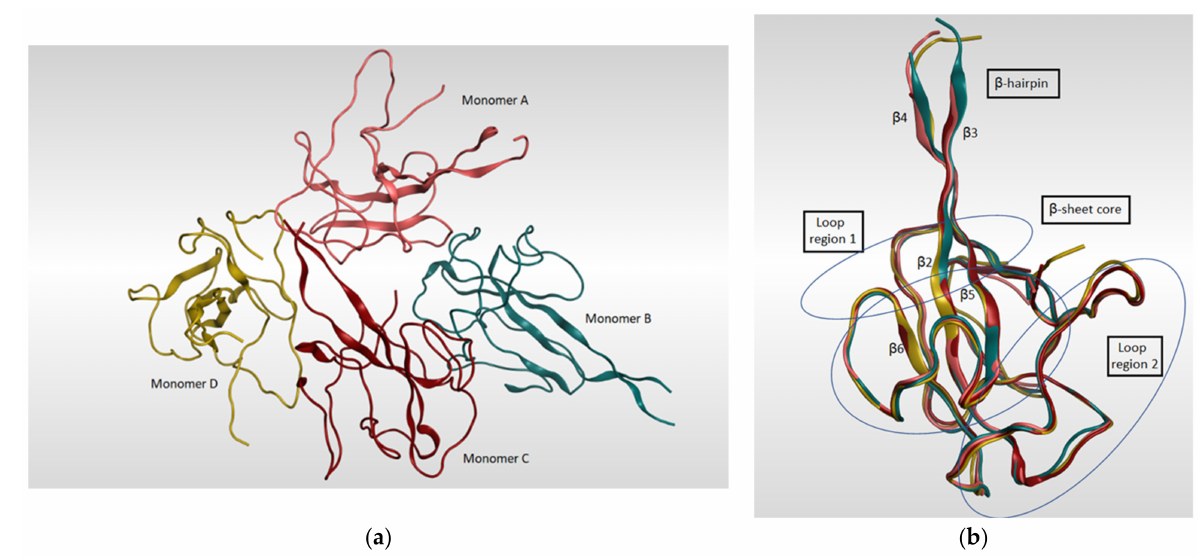
Figure 8. ( a ) Ribbon representation of SARS-CoV-2 nucleocapsid protein N-terminal RNA binding domain (PDB: 6M3M ) which shows four monomers in an asymmetric unit, each colored in different color. ( b ) illustrates the four monomers superimposed on each other and shows the sandwich effect of two loop regions on the β -sheet